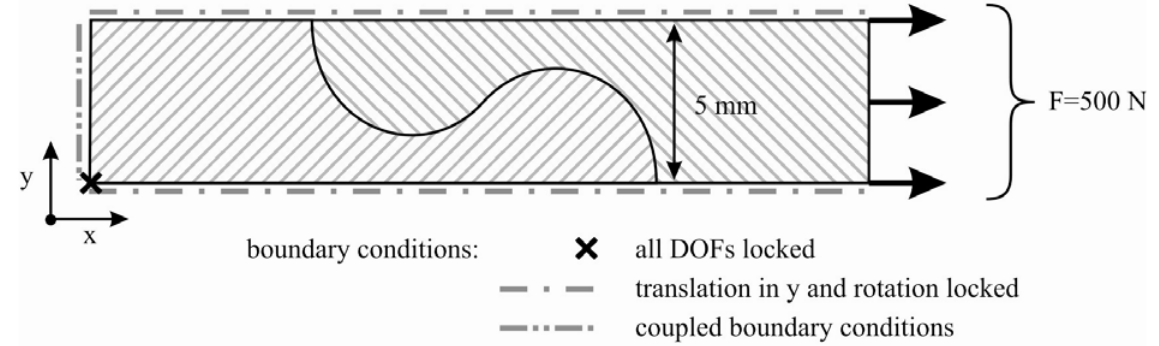
Figure 3. Boundary conditions used for the two dimensional